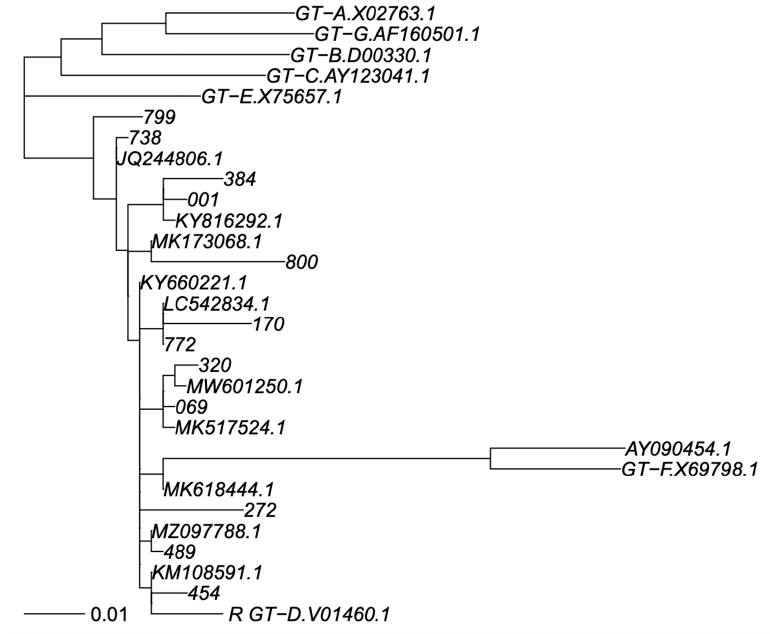
Figure 2. Phylogenetic tree of S sequence fragment. Legend: Phylogenetic tree for genotype clas- sification of S segment. Genotyping reference sequences are labelled “GT-X”, where X indicates genotype, followed by the GenBank accession number. Our new sequences are labelled with a three-digit numerical code, and the closest sequences in GenBank are labelled with their accession number. The scalebar is in units of substitutions/site. Trees were constructed as described in Materials and